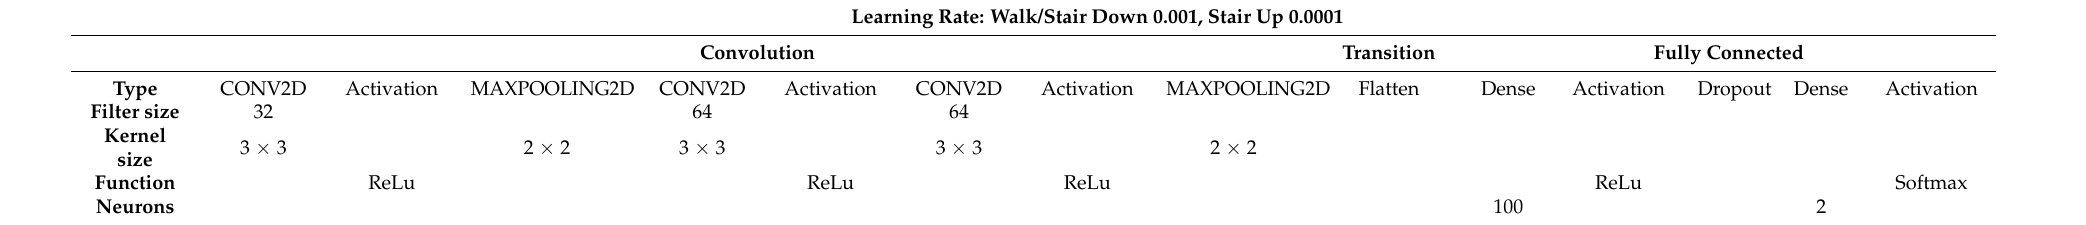
Table A3. Classification Level 3—Walk Swing/Stance and Stair Up/Down